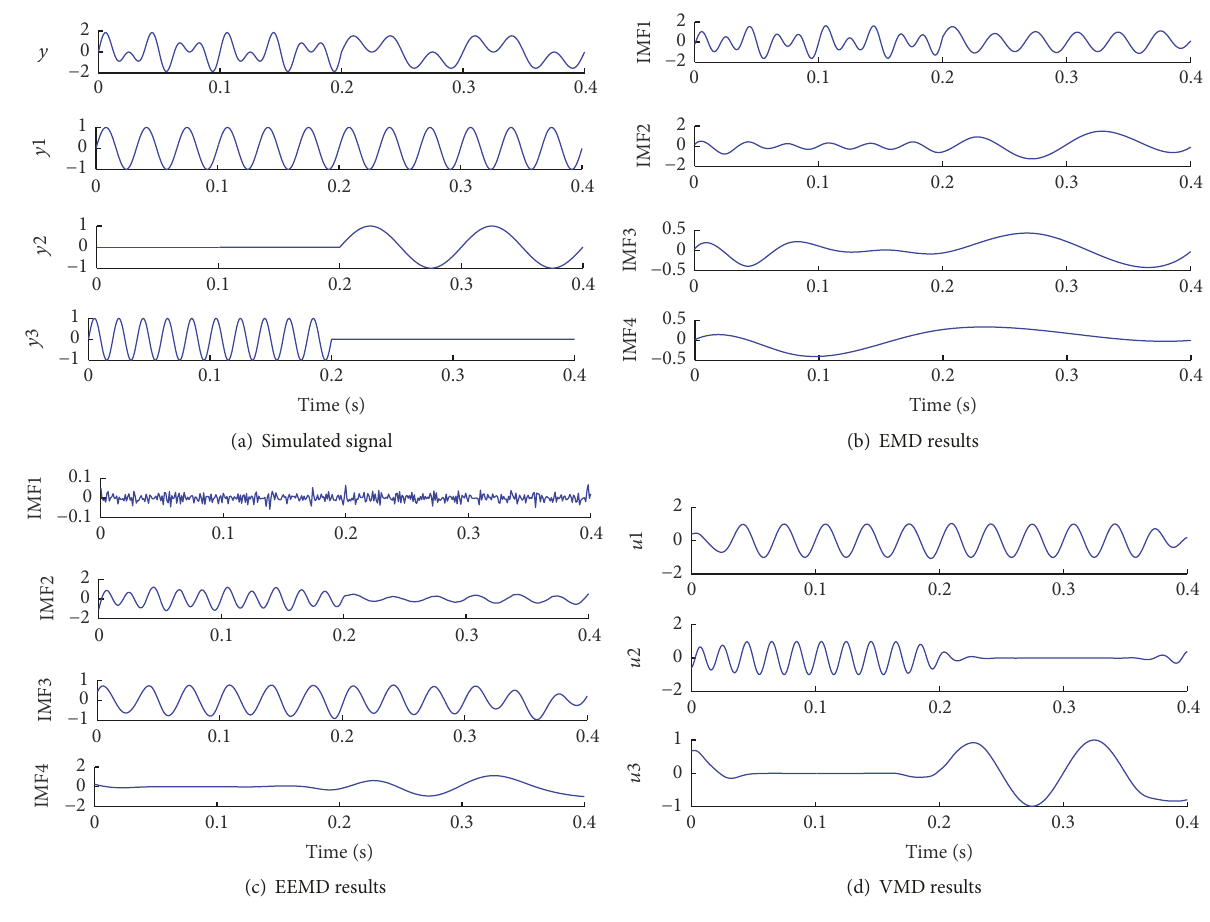
Figure 2: Comparison results of EMD, EEMD, and VMD.